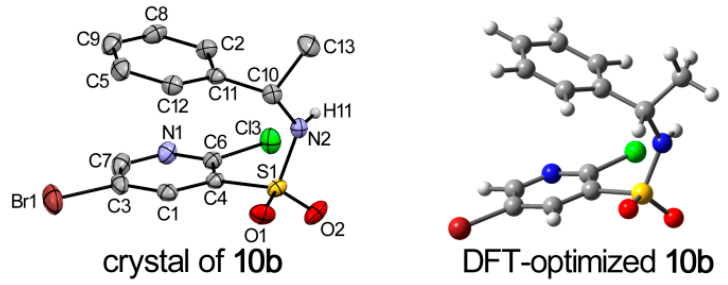
Figure 4. DFT-optimized and crystal structure of 10b ; displacement ellipsoids are drawn at the 30% probability level.